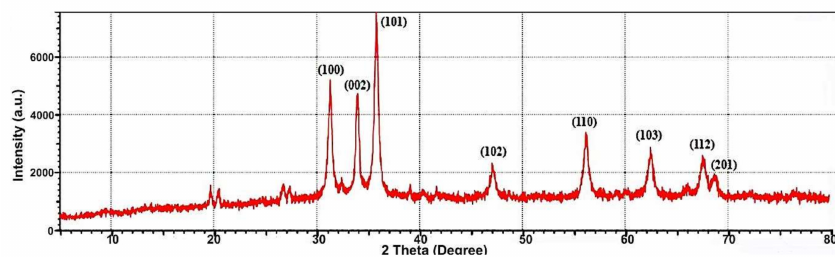
Figure 3. XRD Spectrum of phycosynthesized ZnONPs .